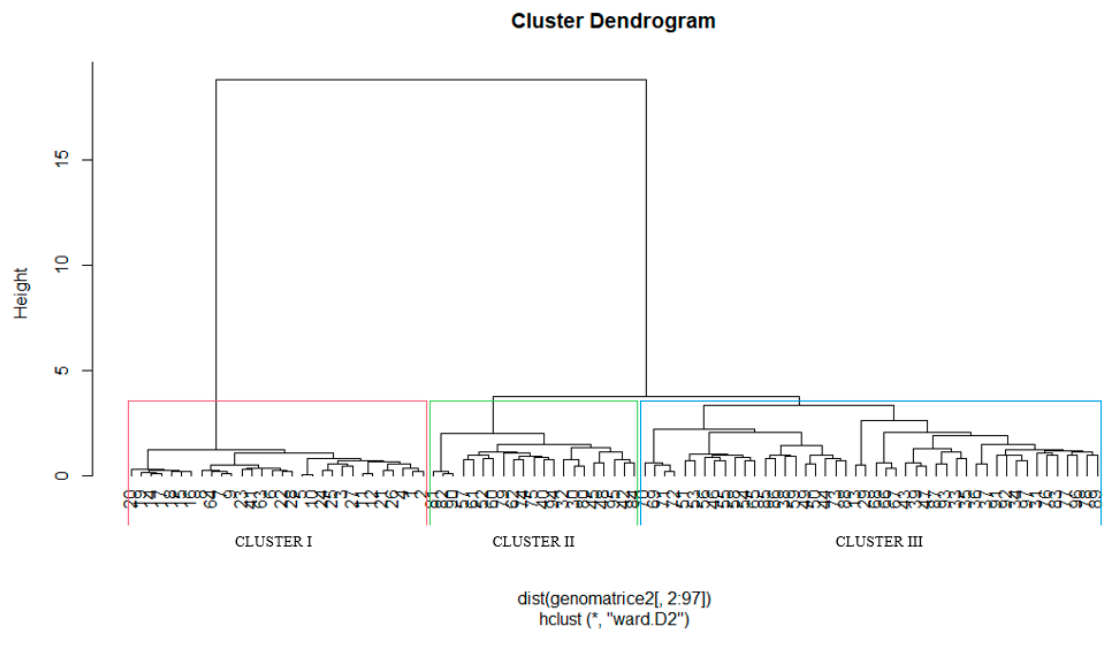
Figure 3. Hierarchical clustering of 97 wheat genotypes based on 16,382 SNP markers. Clusters are separated by color lines.